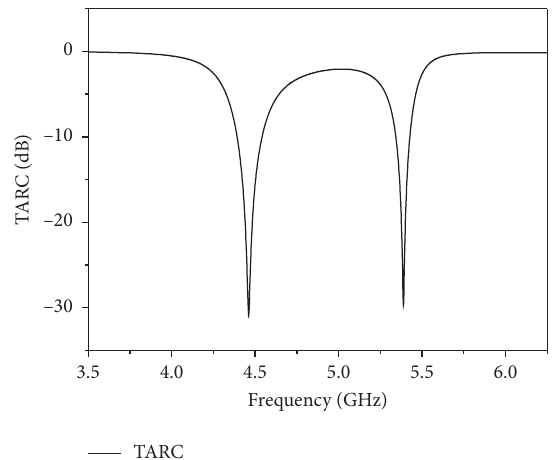
Figure 17: Computed total active reflection coefficient (TARC) of the proposed MIMO antenna.